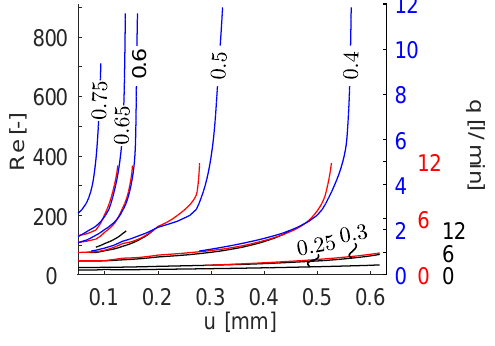
Figure 6: C d (u,Re) for HV(black) HEES(red) HEES+(blue) at 40 ◦ C